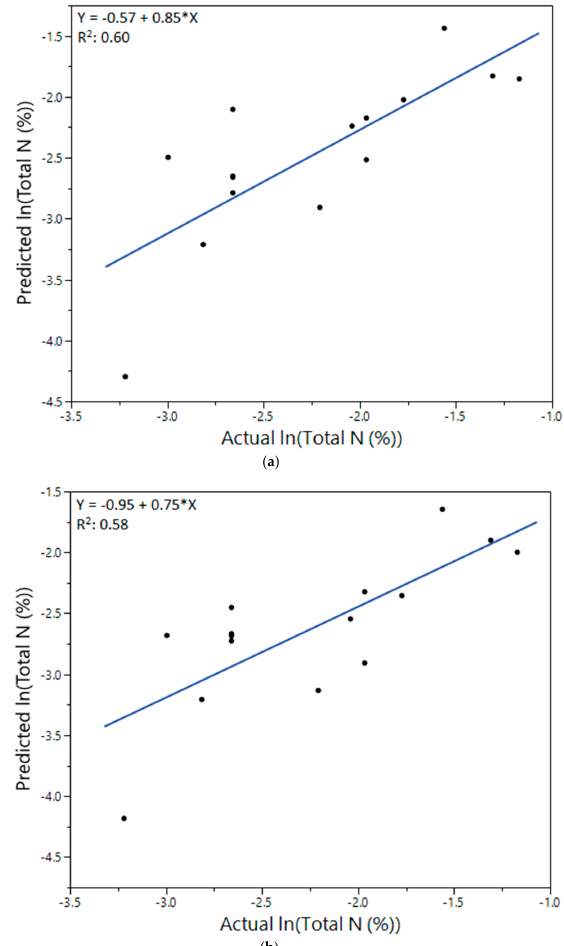
Figure 7. Plots of predicted lnTN (%) versus actual lnTN (%) for validation data sets for dry soil samples of Entisols using ( a ) models which included depth and color variables ( p -value < 0.001), and ( b ) models which included only color variables as predictors ( p -value < 0.001).